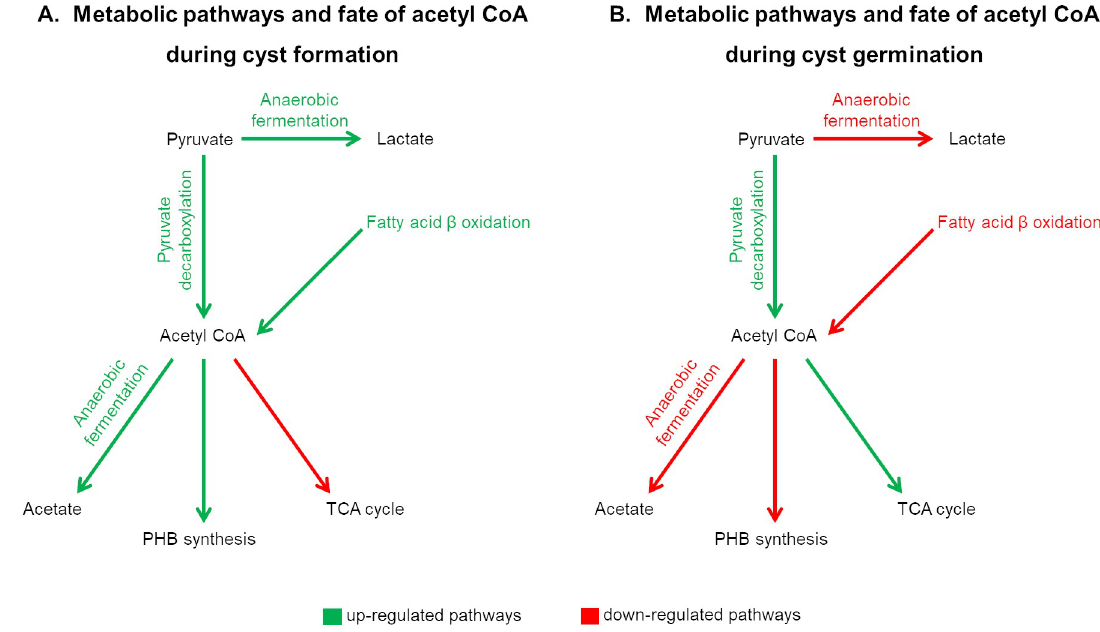
Fig 6. Summary of gene expression changes that affect central metabolism. A) In cells undergoing the formation of cysts, there is increased expression (green arrows) of genes involved in anaerobic fermentation and production of polyhydroxybutyrate (PHB). Concurrently, there is also reduced expression (red arrows) of genes involved in aerobic respiration via the TCA cycle (expression data from [21]). B) In germinating cyst cells there is increased expression of genes promoting aerobic energy production via the TCA cycle as well as a reduction in anaerobic fermentation and PHB